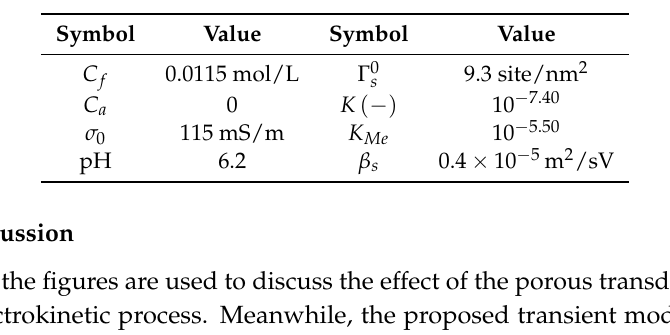
Table 2. Related parameters of the NaCl solution in the experimental test.